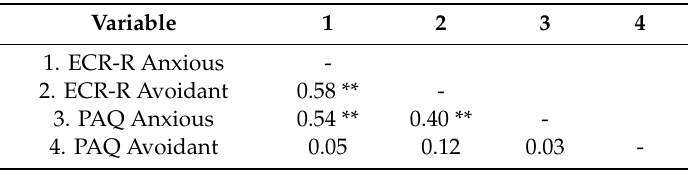
Table 4. Correlations for Study Variables.